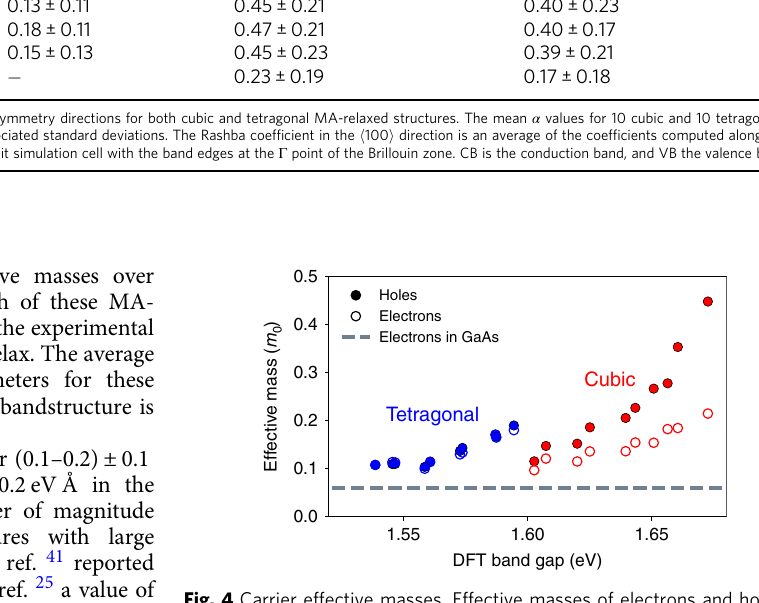
Fig. 4 Carrier effective masses. Effective masses of electrons and holes in the cubic (red) and tetragonal (blue) MAPbI 3 phases versus the band gap, shown for 10 structures (in each phase) that differ only for their MA random alignment. The dotted line given for comparison is the electron effective mass of GaAs. The LDA band gaps were shifted by ~1.2 eV to match the experimental